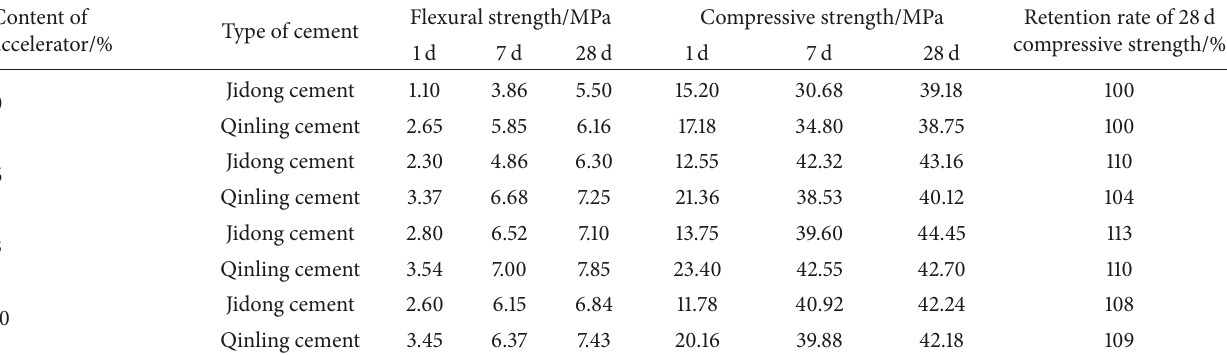
Table 3: The effect of content of accelerator on strength of cement mortar.